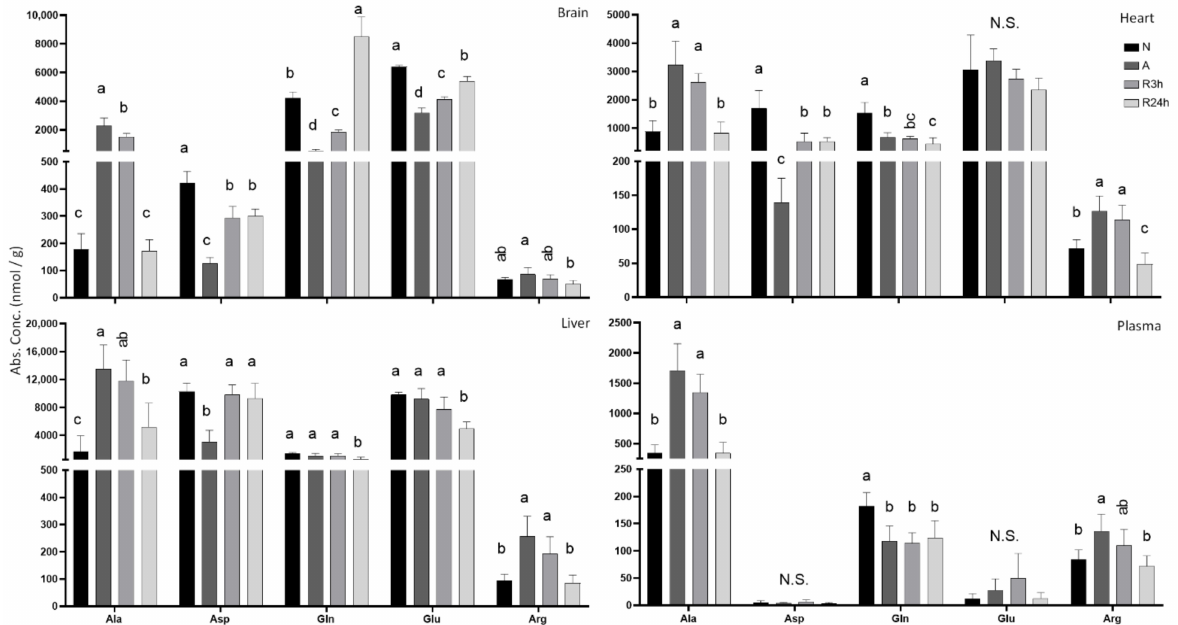
Figure 10. Amino acids of particular interest. Graphs of absolute concentrations of detected amino acids alanine, aspartate, glutamine, glutamate, and arginine for brain, heart, liver, and blood plasma. N, normoxia (control); A, anoxia; R3h, 3 h reoxygenation; R24h, 24 h reoxygenation. Different letters indicate statistical differences between groups calculated using one-way ANOVA with Tukey’s post-hoc ( p -value ≤ 0.05). Note that y-axis limits are different. Data are presented as means ± S.D. Values as reported by